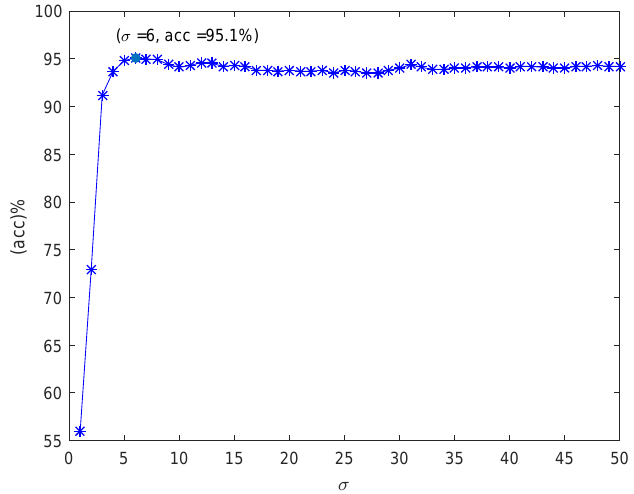
Figure 4. The evaluation of parameter σ